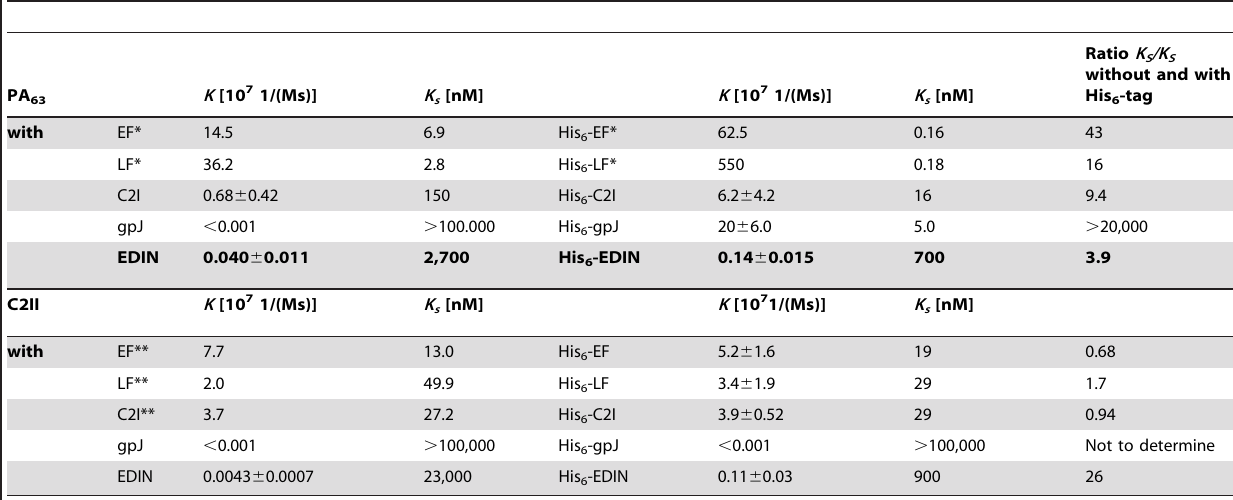
Table 1. Stability constants K and half saturation constants K s for binding of proteins with and without His 6 -tags to membrane channels formed by anthrax PA 63 and